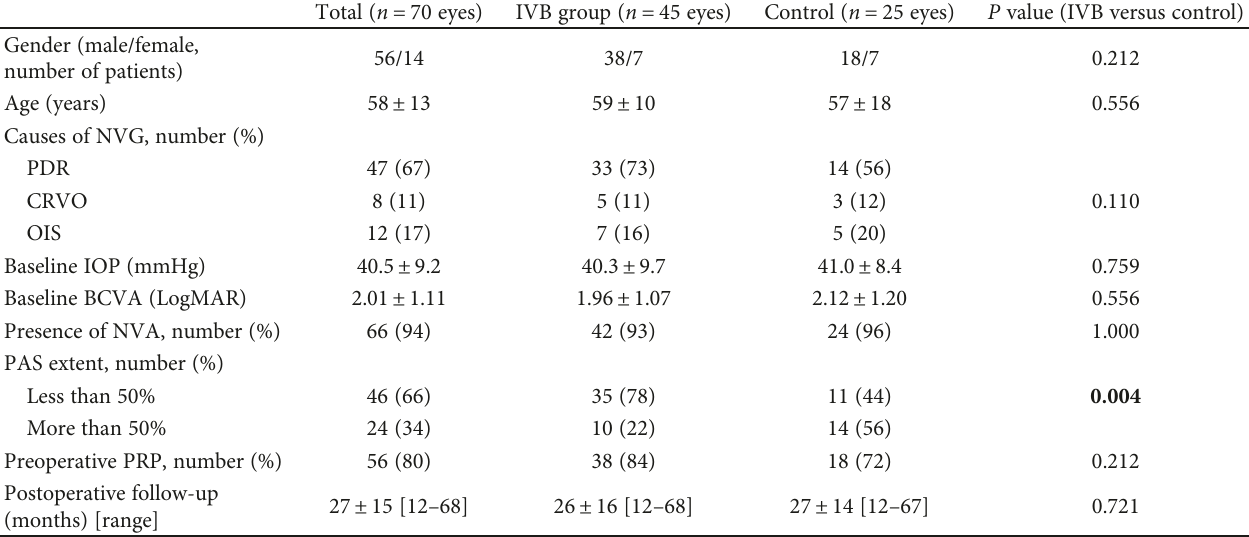
Table 1: Baseline demographics and ocular characteristics of participants (total of 70